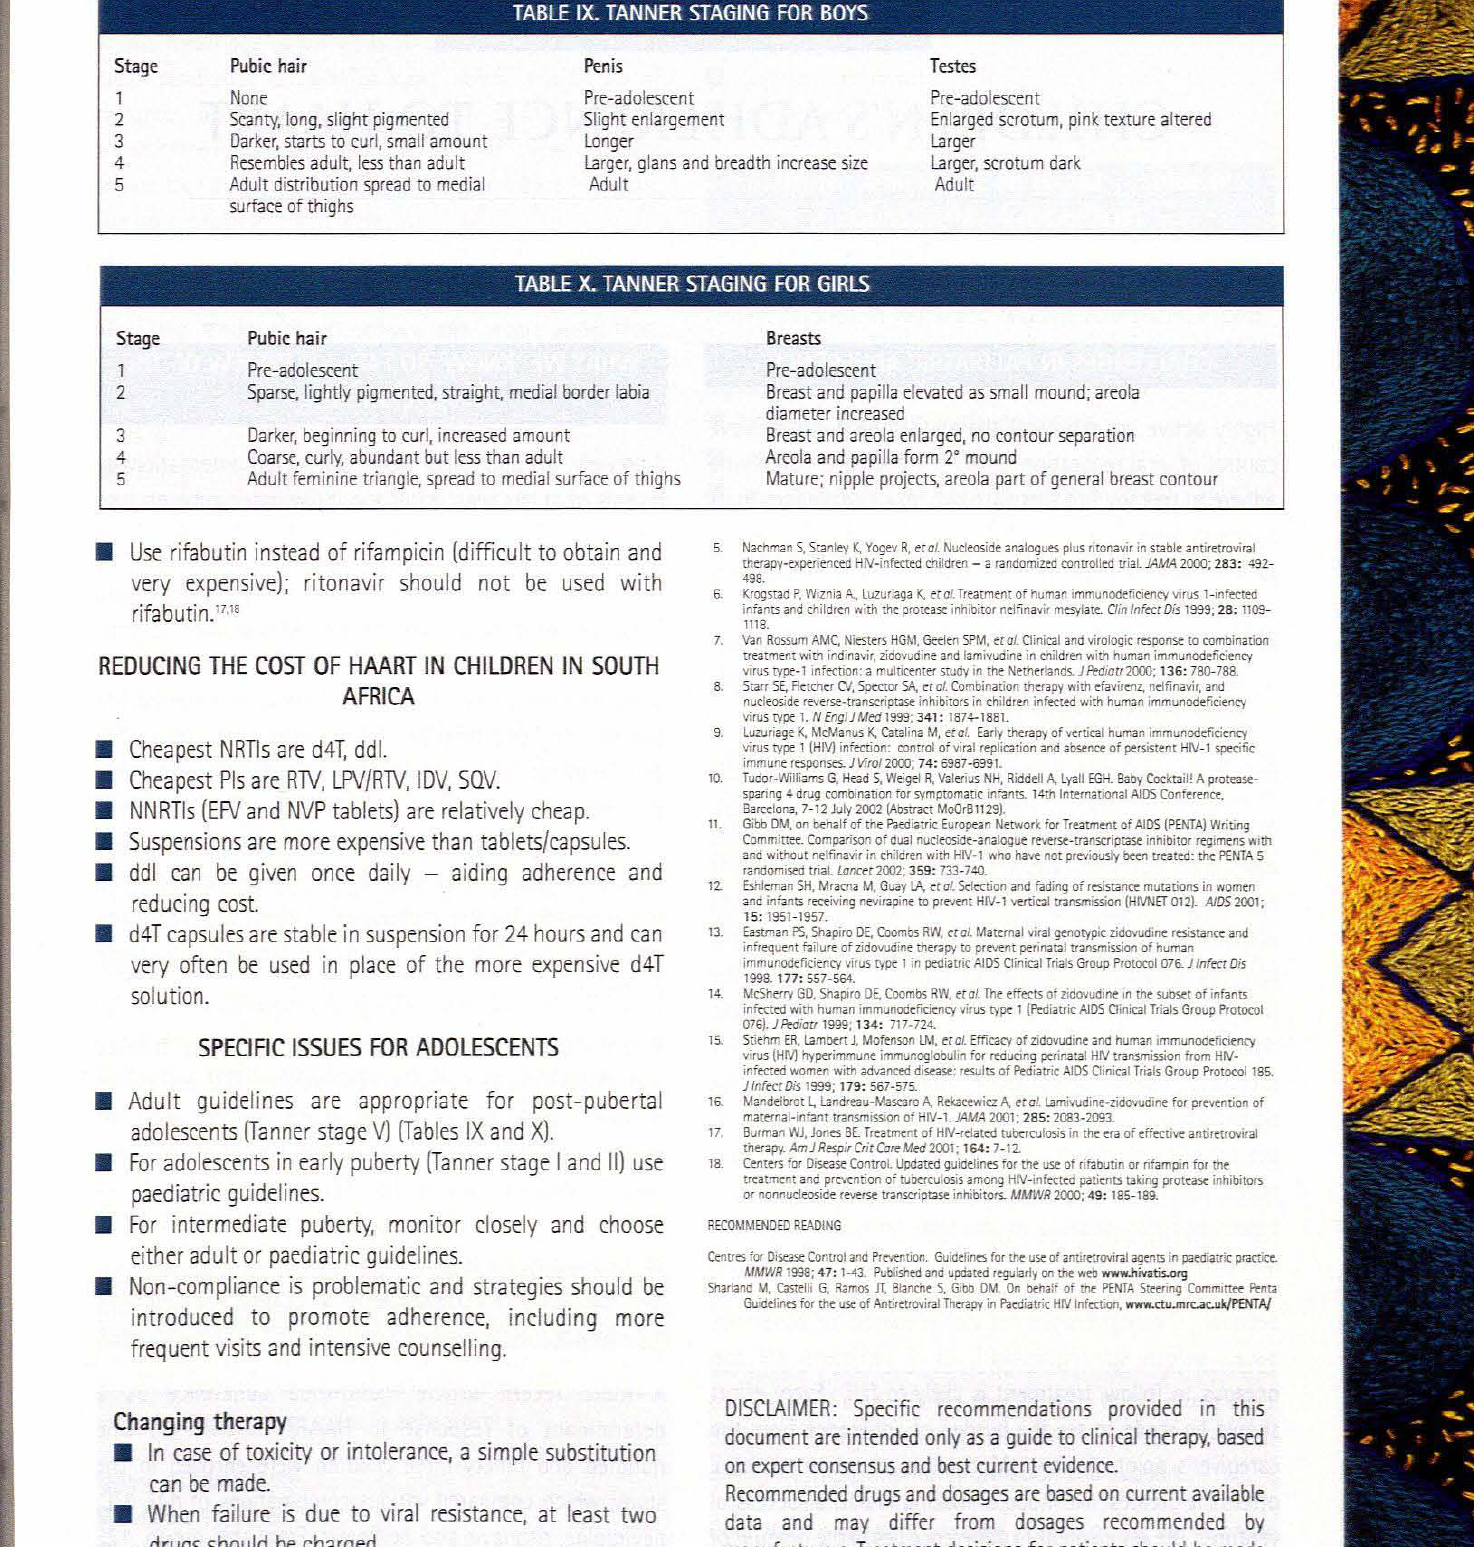
Penis Pre-adolescent Slight enlargement longer larger, glans and breadth increase size Adult